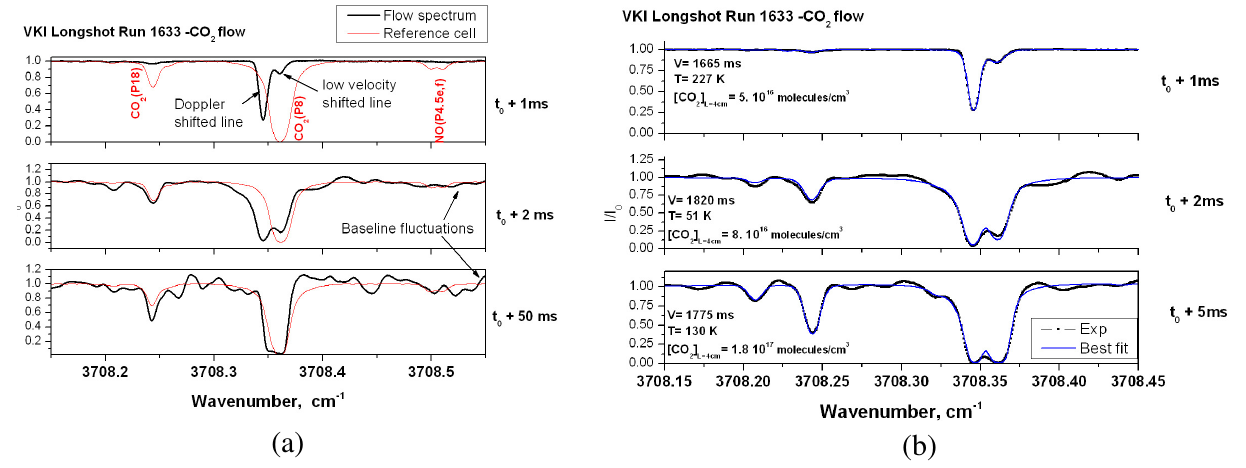
Figure 5. Wavelength and intensity calibrated spectra at different instances of the flow (a) and spectrum inversion